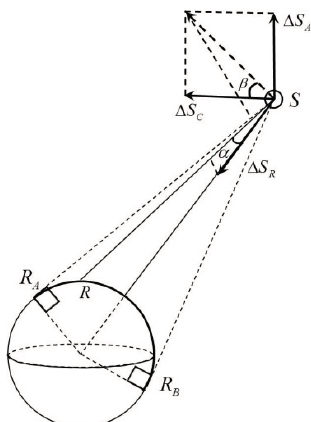
Figure 2. The geometry relationship between the orbit error (radial, along, and cross direction) and the satellite to receiver direction. (R: rover; R A and R B : rover position with altitude angle of zero; S: